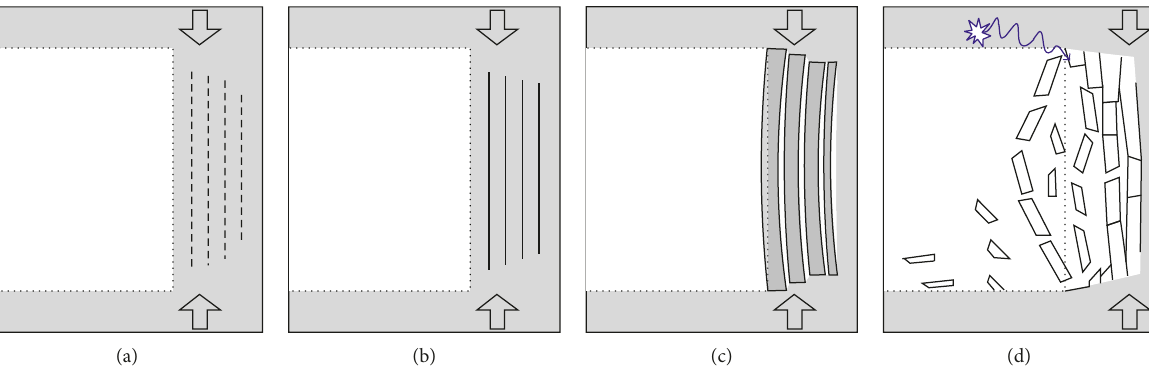
Figure 9: Schematic diagram of the occurrence mechanism of rock burst: (a) crack initiation and propagation, (b) formation of the layer- crack structure, (c) strain energy accumulation, and (d) occurrence of dynamic